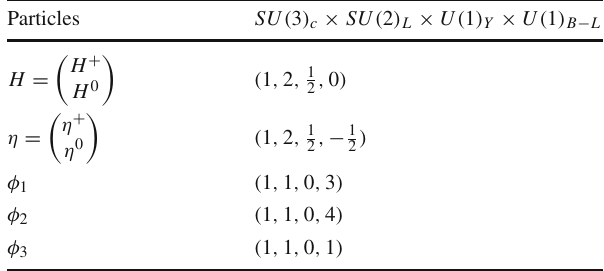
Table 2 Scalar content of the minimal